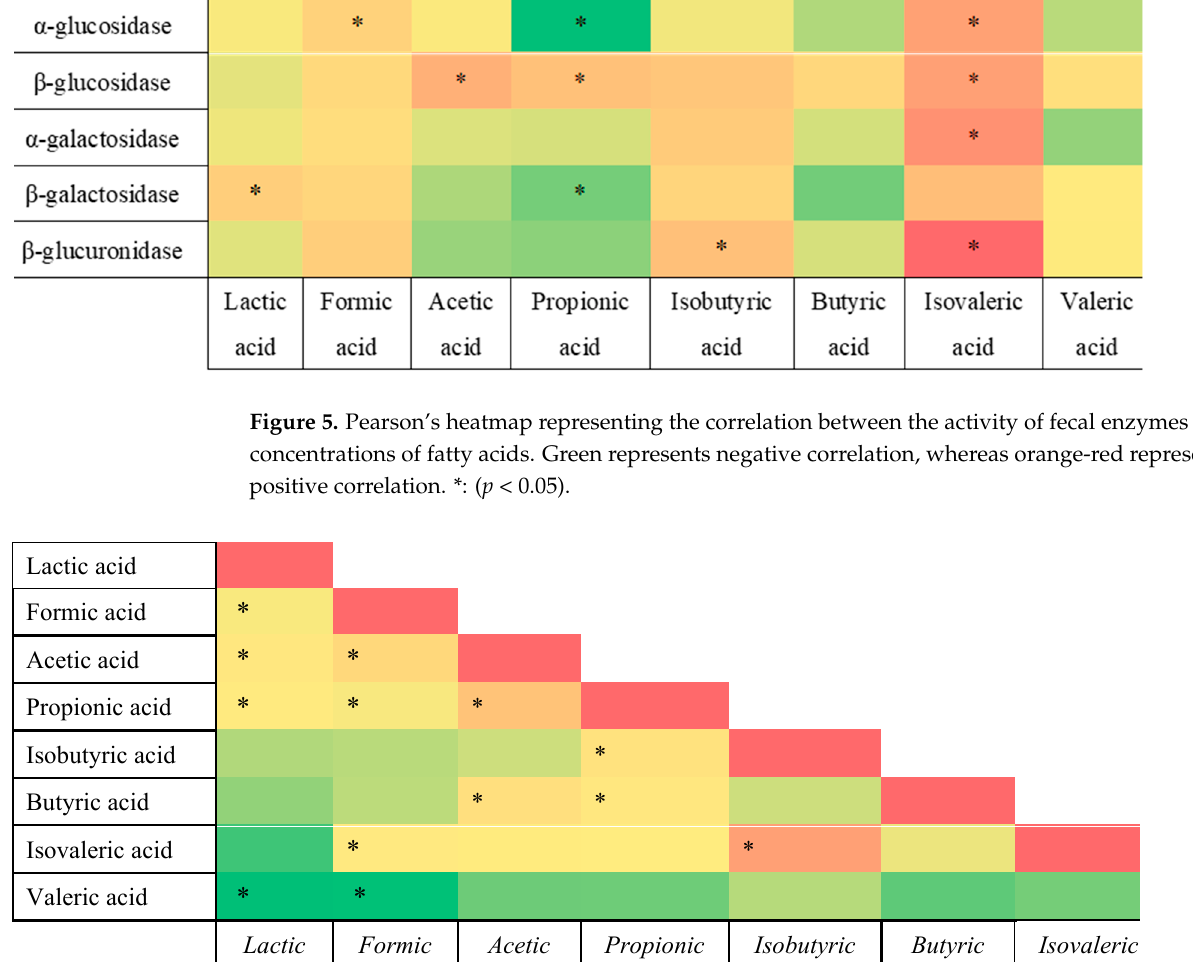
Figure 6. Pearson’s heatmap representing correlation between the concentrations of fatty acids. Green color represents negative correlation, whereas orange-red represents positive correlation. *: ( p < 0.05).